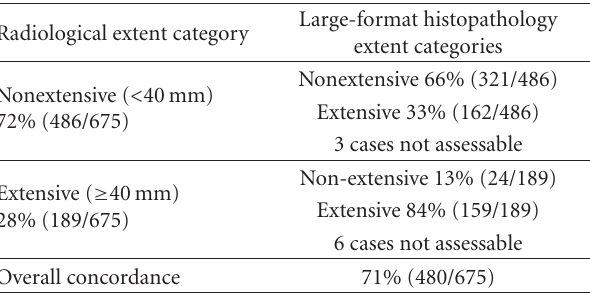
Table 3: Concordance of radiological and pathological extent categories in 675 consecutive breast cancer cases, Falun,